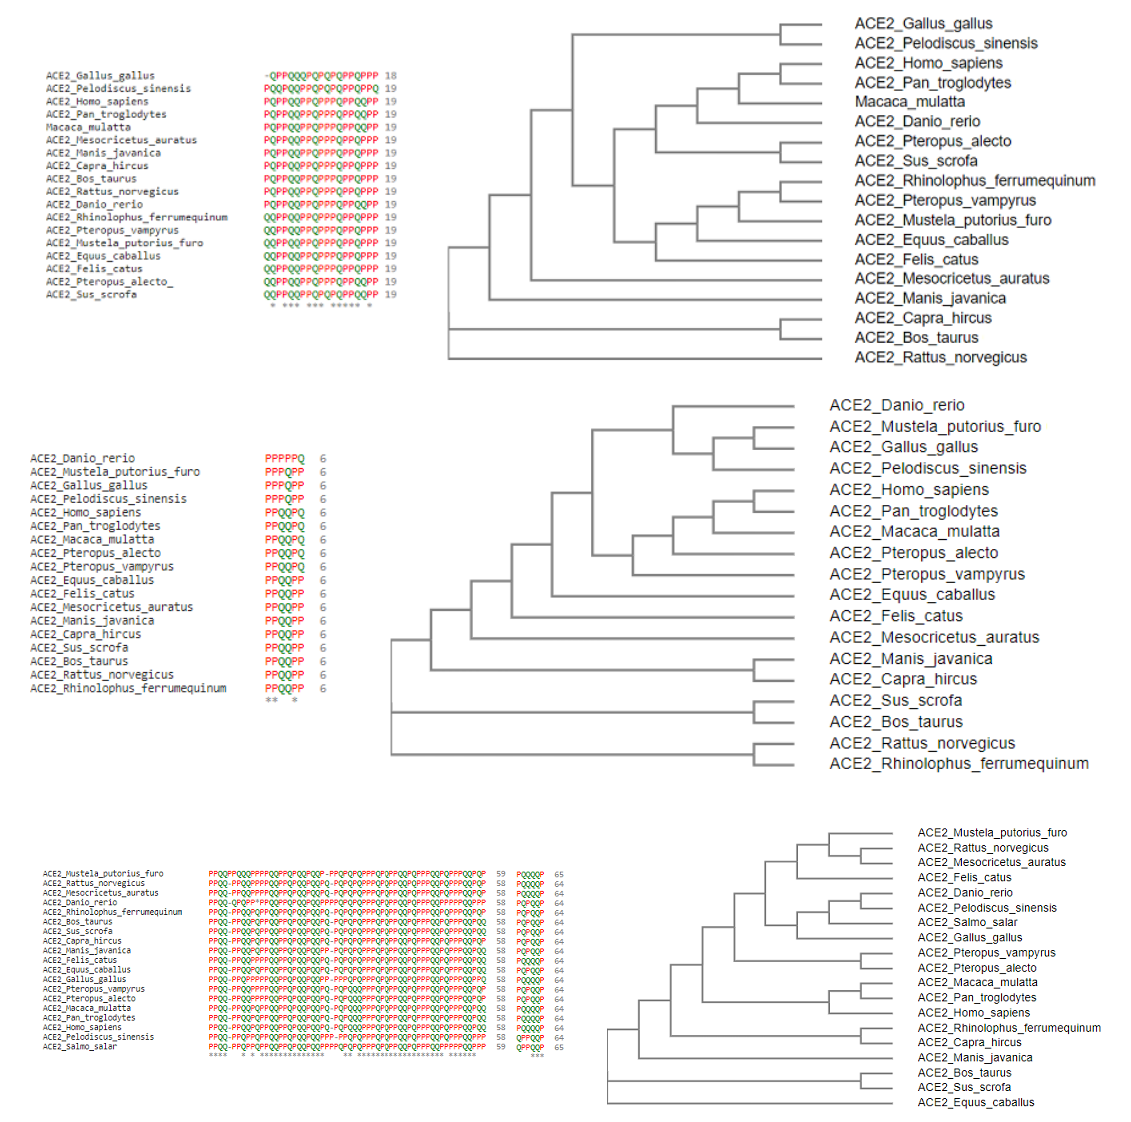
Figure 11. Polarity sequence of the D1, D2, and D3 domains across all species alignment and associated phylogenetic